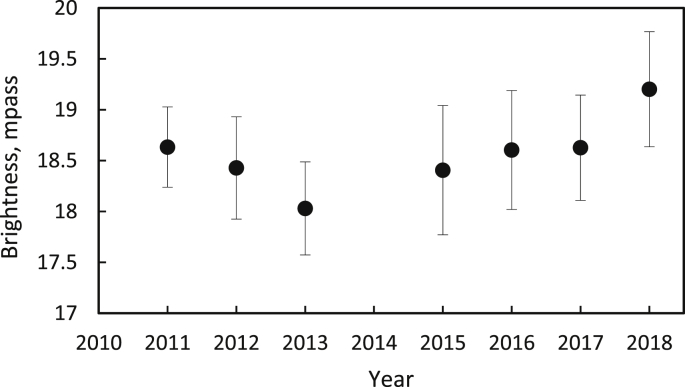
Yearly average sky brightness.